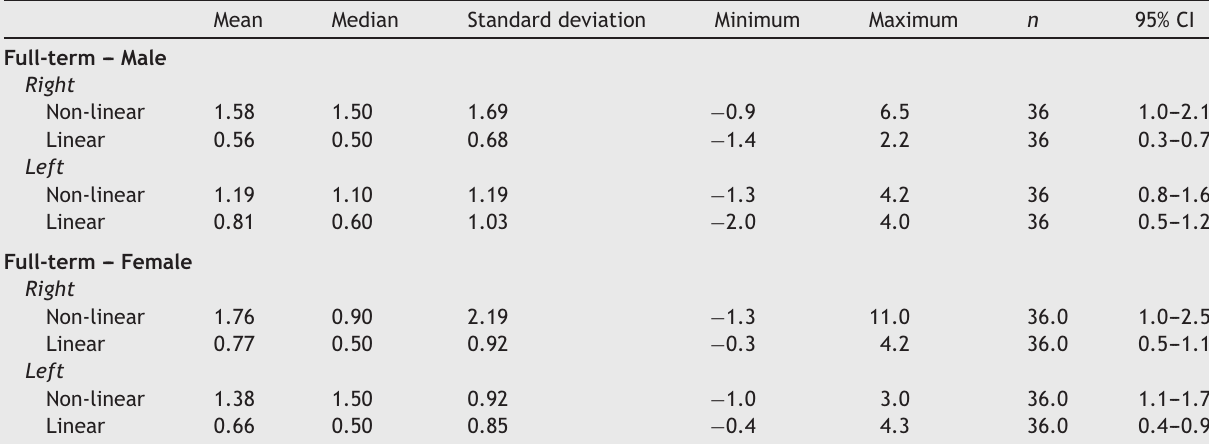
Inhibitory effect of efferent TEOAE with linear and nonlinear clicks (dB SPL) for full-term neonates. Mean Median Standard deviation Minimum Maximum n 95% CI